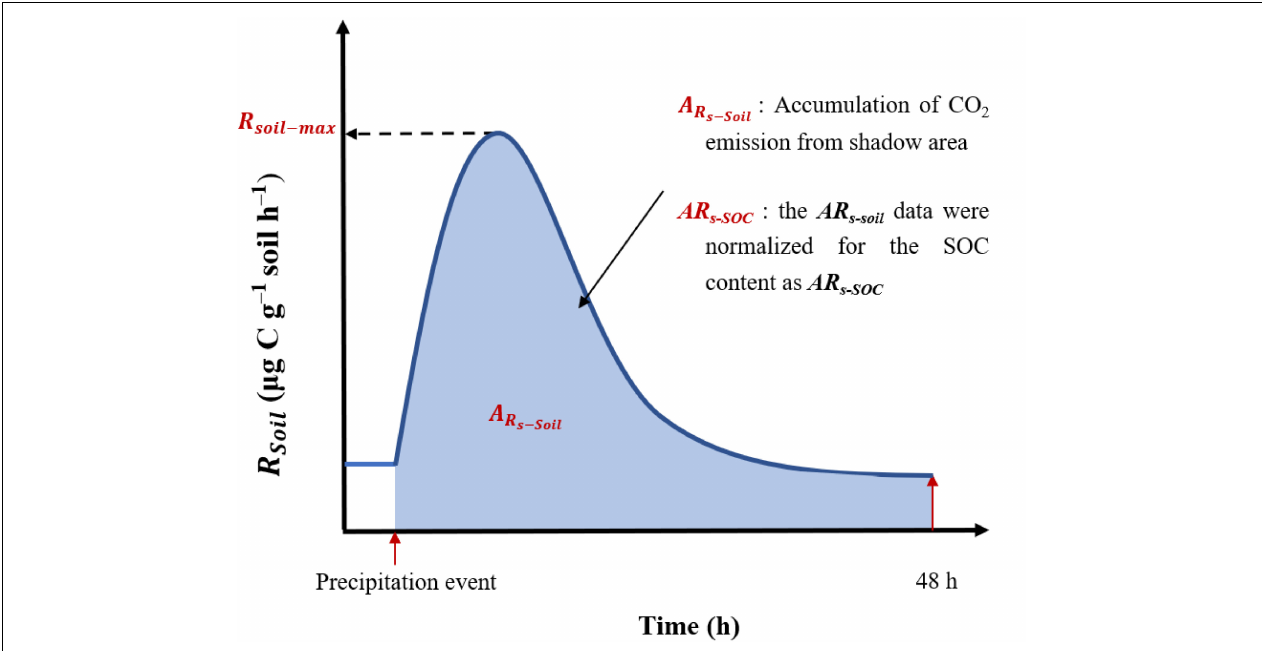
FIGURE 1 | Example of a pulse effect (soil CO 2 emissions) in response to a simulated precipitation event. Precipitation event stand pulse precipitation; Time (h) represents the duration of the precipitation pulse effect; 48 h represents 48 h after of precipitation pulse occurrence. R soil , soil respiration rate; R soil − max , soil maximum respiration